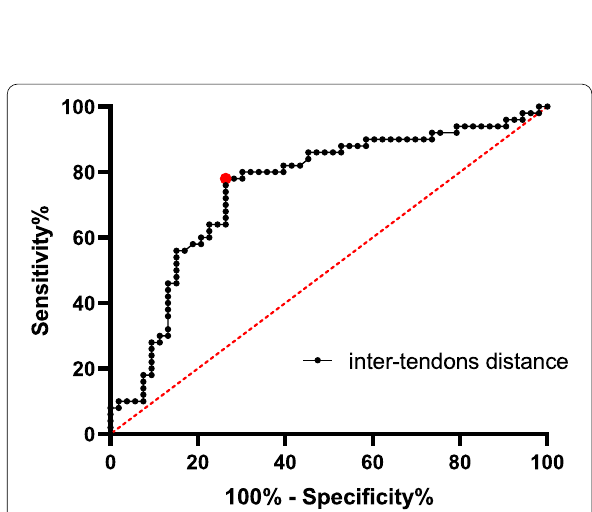
Fig. 3 Receiver operating curve and calculation of the area under the curve also indicate that inter-tendon distance has a good ability in predicting anterior supraspinatus insertion injury (AUC